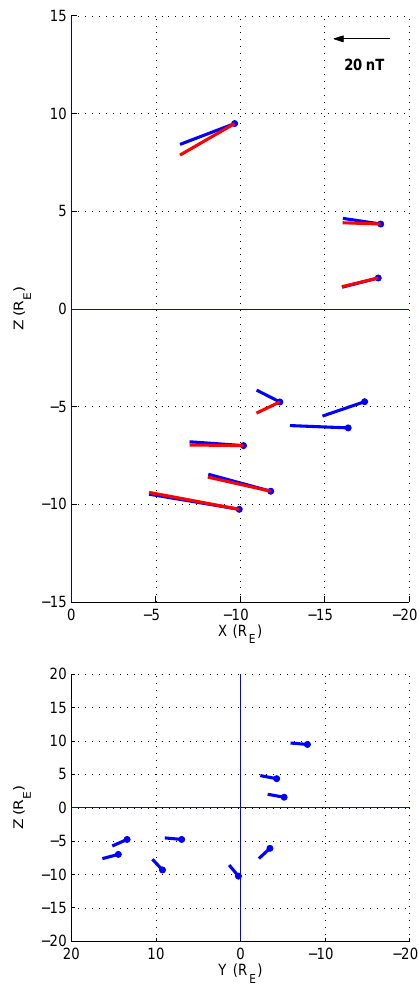
Fig. 7. (left) Locations of the maximum variance vectors ( ˆ e x ∗ ) pro- jected onto the GSM XY plane (blue). The root of the vector has been placed at the spacecraft location at the time of the event. The length of the each vector represents the unperturbed magnetic field magnitude, normalized to the scale shown by the arrow. Circles show the spacecraft position at the time of the SI event. Red lines show the projected shock normal direction for each SI event that was associated with a shock. Note that the shock normal direc- tions are defined to point in the direction of the upstream solar wind. (right) Unit intermediate variance vectors ˆ e x ∗ projected in the GSM YZ plane. Circles show the spacecraft position at the time of the SI event.